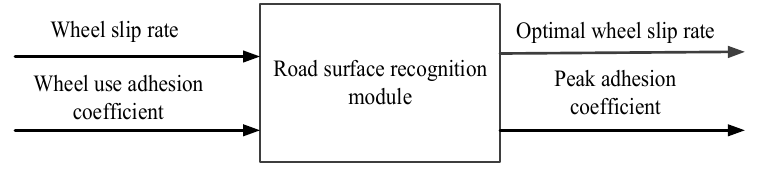
Figure 4. Relationship between adhesion coefficient and slip rate.